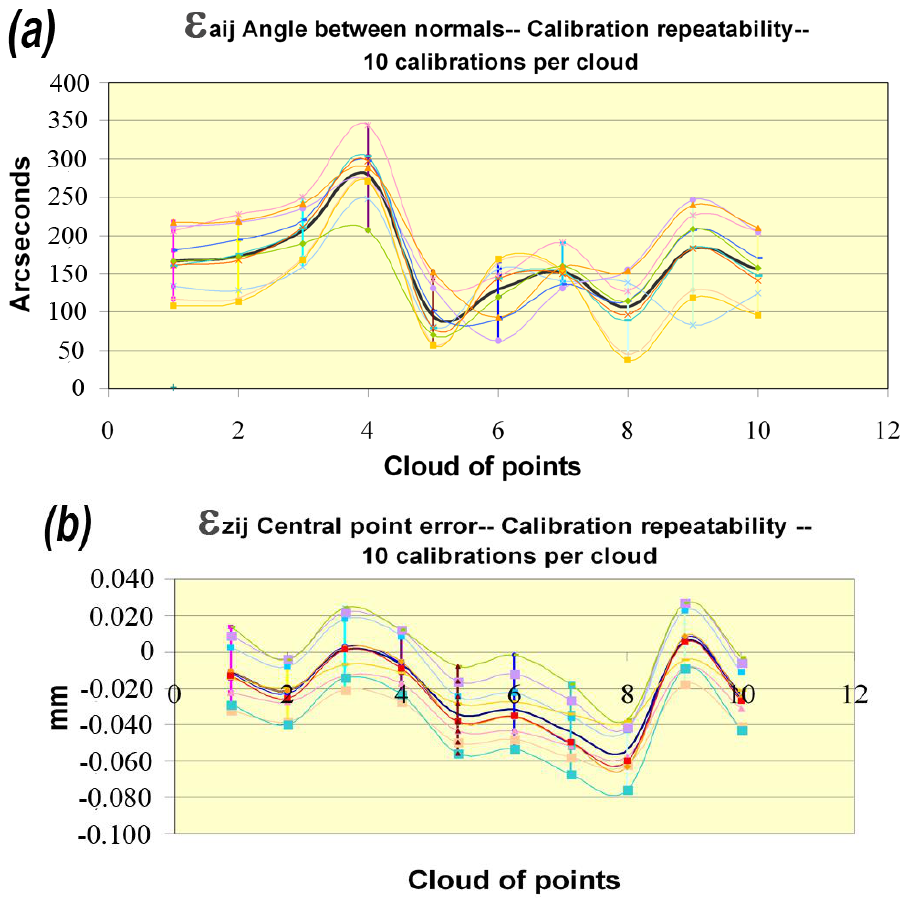
Figure 11. System repeatability and calibration process influence: (a) Angle between normals. (b) Projected central point